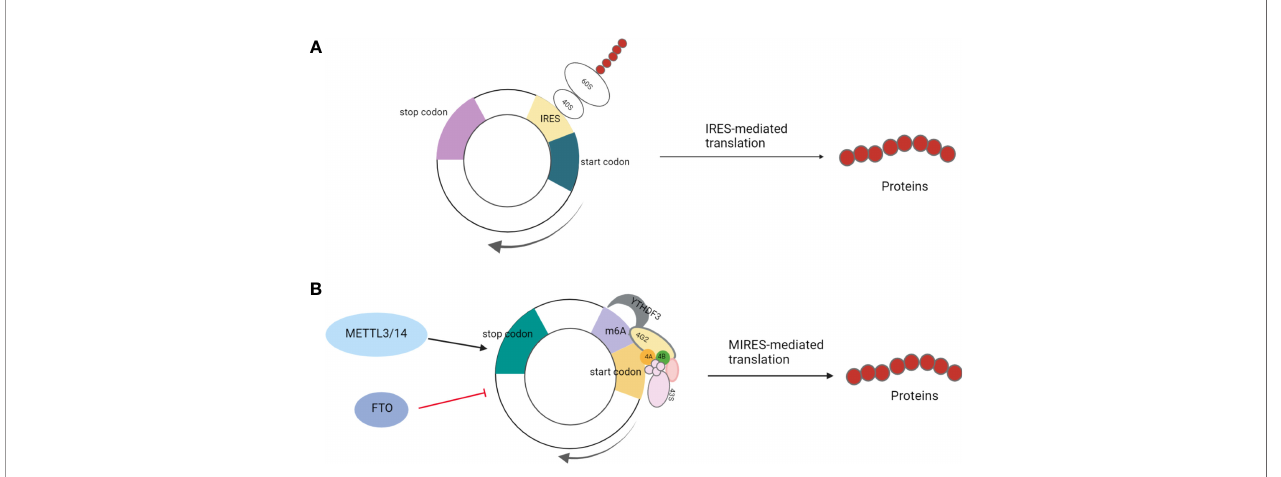
FIGURE 1 | (A) IRES-mediated translation: Under physiological and environmental stresses, such as hypoxia, heat shock, or viral infection, eukaryotic mRNA initiates IRES-mediated translation to compensate for defective cap-dependent translation; (B) MIRES-mediated translation: In cooperation with the initiation factor eIF4G2 and the m6A reader YTHDF3, a single m6A site is suf fi cient to initiate circRNA translation. This mode of translation is enhanced by methyltransferase METTL3/14 and inhibited by the demethylase